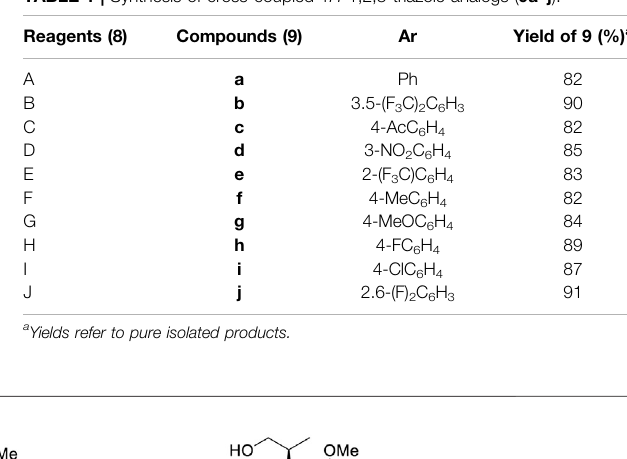
TABLE 1 | Synthesis of cross-coupled 1 H -1,2,3-triazole analogs ( 9a – j